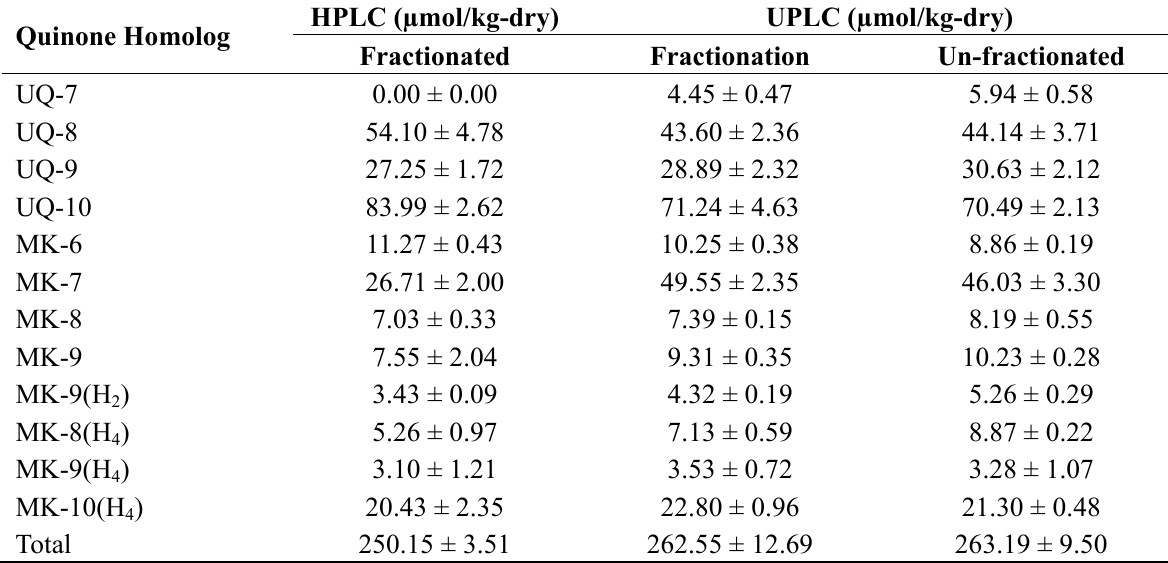
Table 1. The comparison of HPLC and UPLC for the analysis of UQs and MKs in the anaerobically digested sludge (mean ± SD, n =